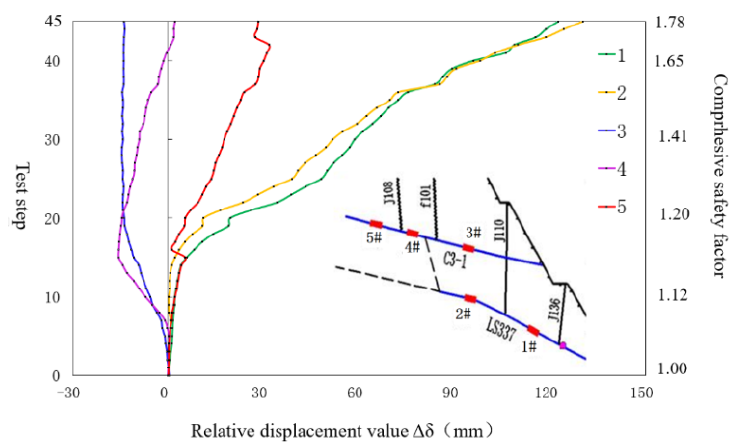
Figure 10. Relative displacement curve of LS 337 and C 3-1 .